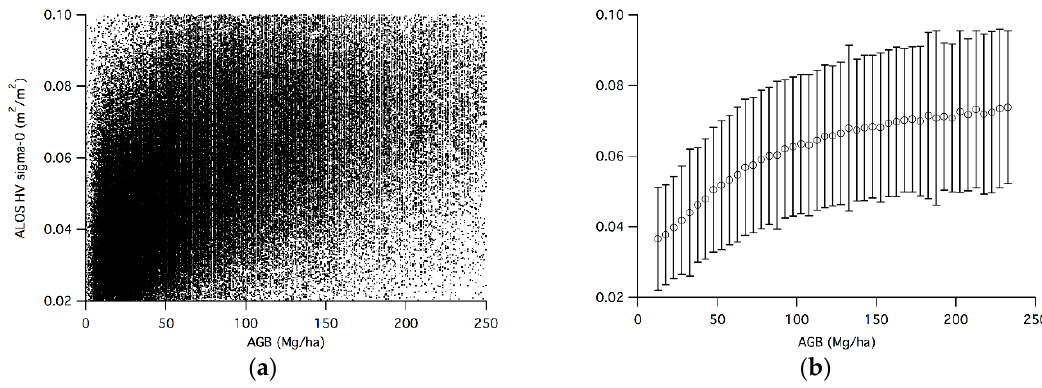
Figure 1. Correlation between GLAS-derived AGB (Mg·ha − 1 ) and ALOS backscatter coefficient sigma-0 for North American boreal forest. ( a ) shows all GLAS shots and corresponding sigma-0 values from the pixel that the GLAS shot falls on; ( b ) shows the mean (circle) and ±1 standard deviation (bar) of ALOS HV sigma-0 values by binning the shots into 5 Mg·ha − 1 bins. Bins below 10 Mg·ha − 1 and above 235 Mg·ha − 1 are removed as outliers.